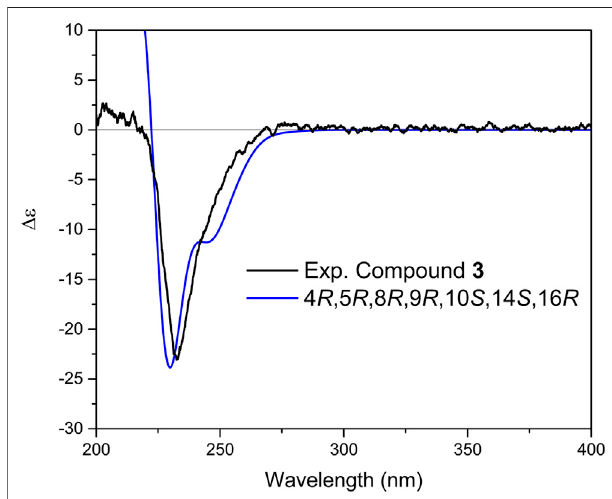
FIGURE 6 | Comparison of experimental and calculated ECD spectra of compound 3 at TD-DFT/B3LYP/6-31+G(d,p) basis set and level of theory in acetonitrile.